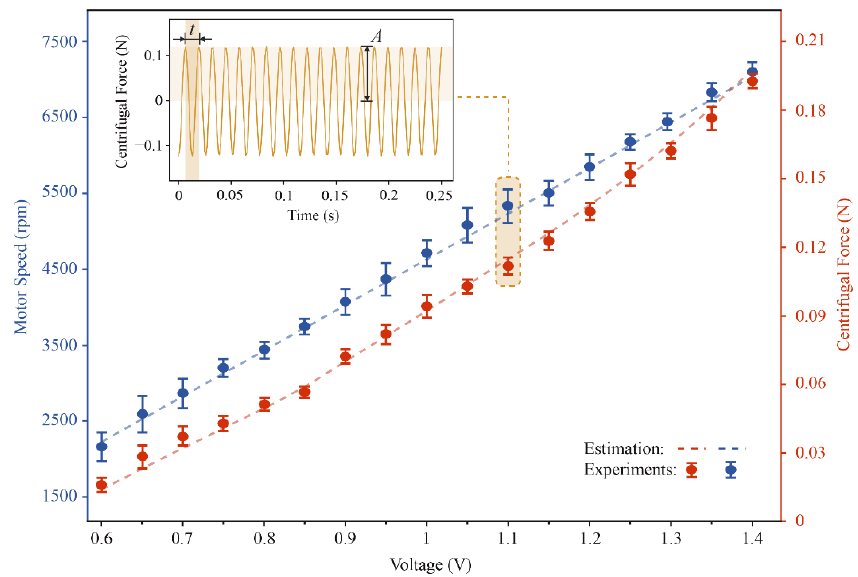
Figure 7. The motor speeds and centrifugal force on different voltages. The centrifugal force of the motor while the motor is powered on 1.1 V.